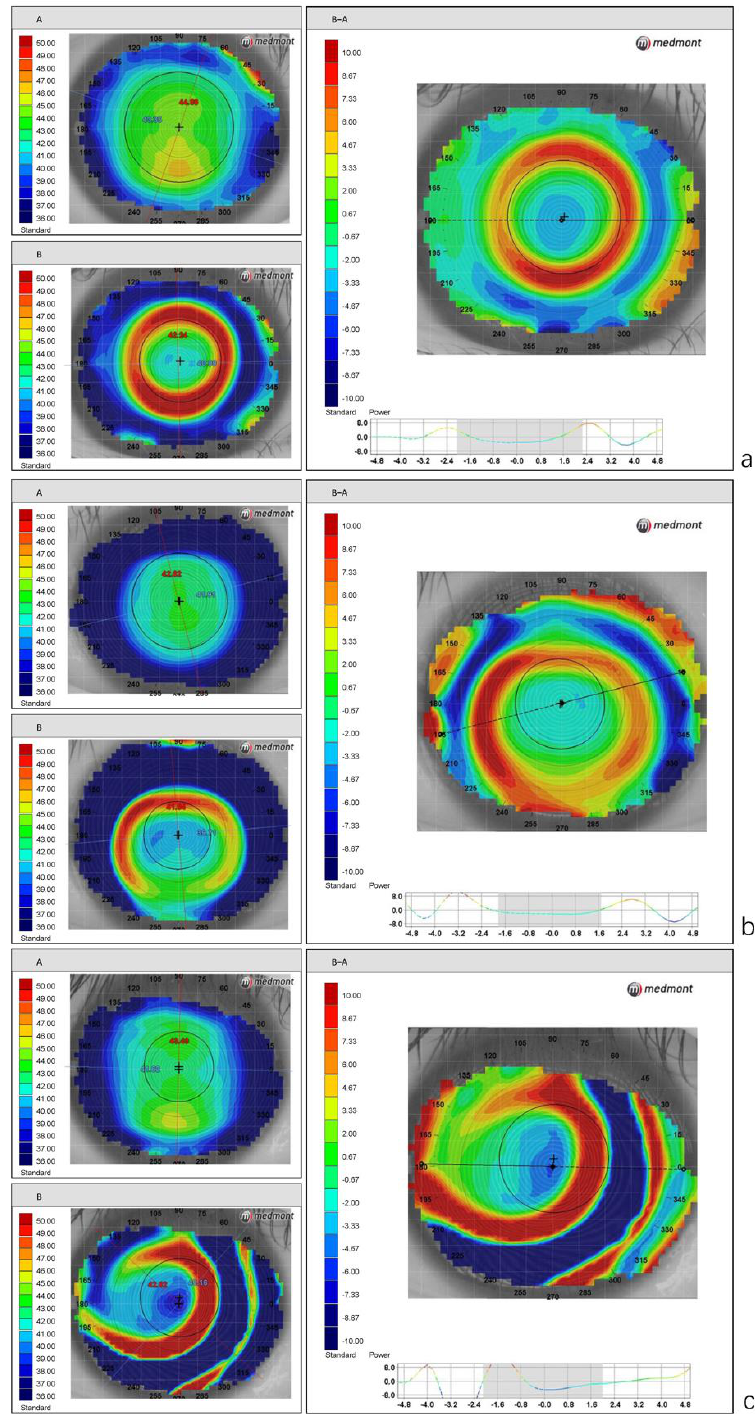
Figure 2. The three types of difference maps after orthokeratology lens wearing, based on the intactness of the plus power ring and amount of decentration. ( a ) Type I: intact plus power ring; well centered with decentration ≤ 0.5 mm. ( b ) Type II: intact plus power ring; acceptable centration with decentration of ≤1 mm. ( c ) Type III: incomplete plus power ring or decentration of >1 mm.